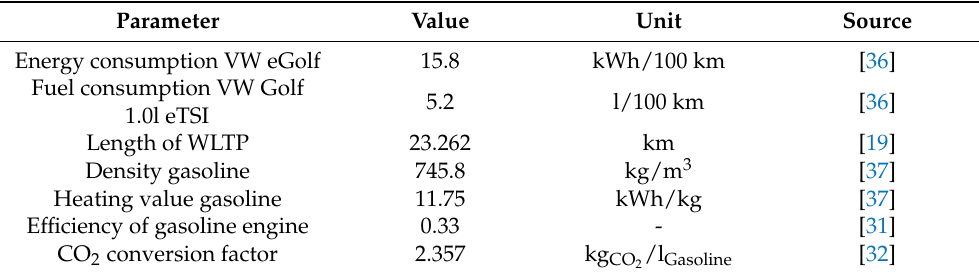
Table A1. Technical data of reference